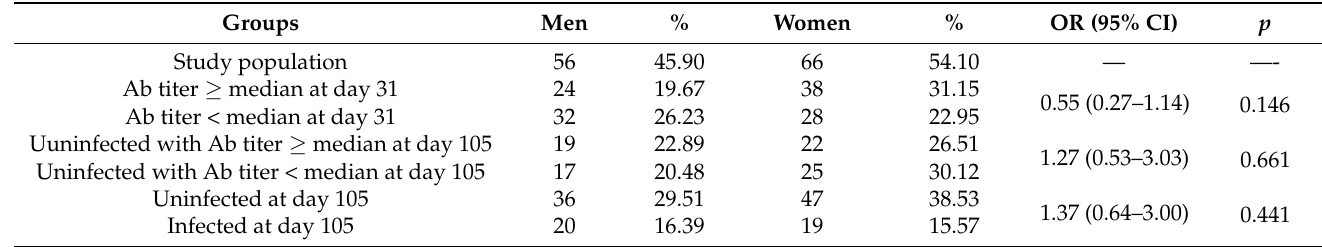
Table 5. Analysis of the significant differences in gender distribution between different groups and subgroups.